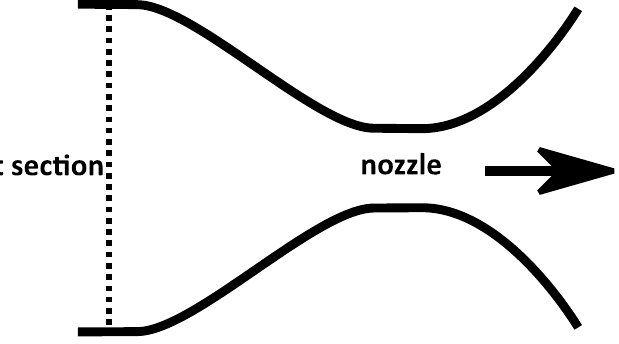
Figure 1. Isentropic flow in a convergent–divergent nozzle.